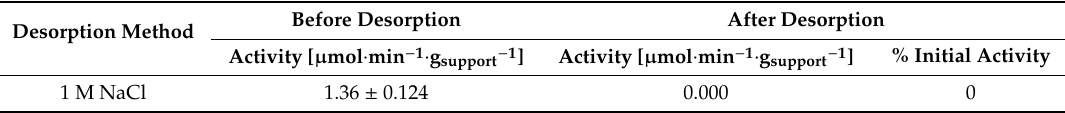
Table 2. Activity of naringinase immobilized on chitosan microsphere before and after treatment with 1 M